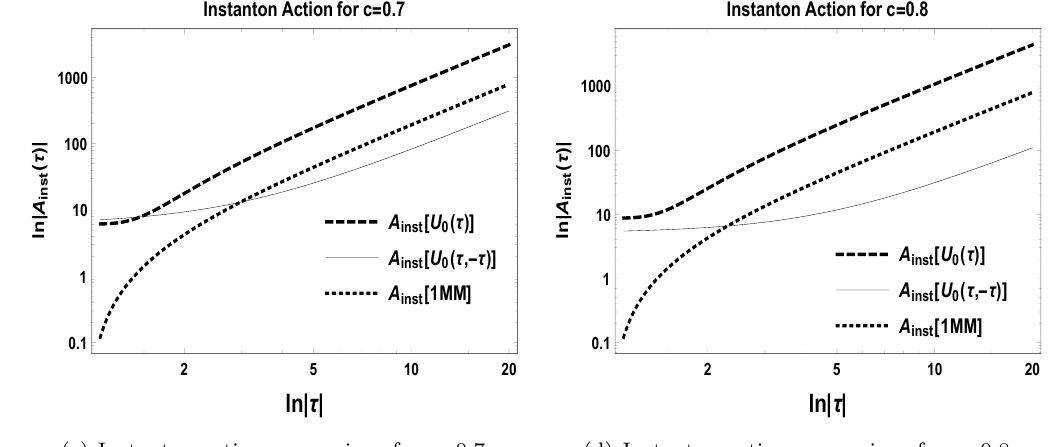
Figure 15 . Instanton action from One-point function (eq. (5.11)), from two-point function (eq. (5.16)) is compared with know eigenvalue instanton action for one matrix model (eq. (5.17)). We have scaled them appropriately to show their same nature in large τ